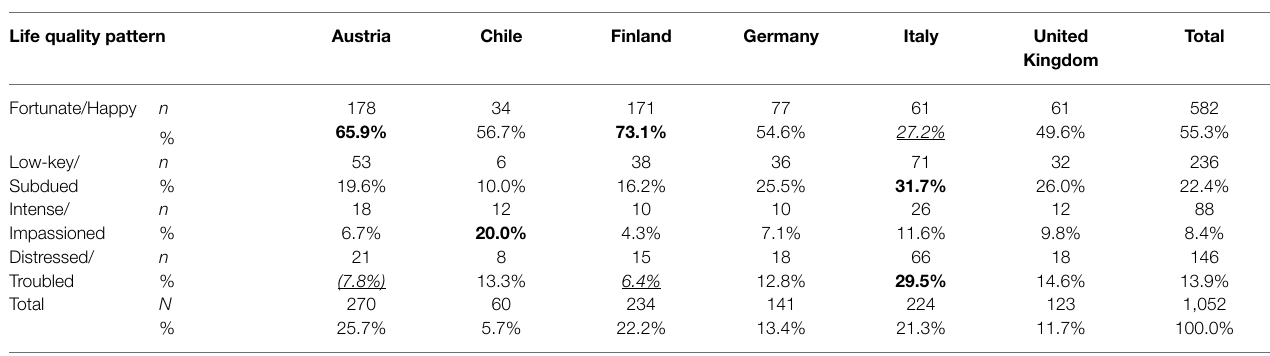
TABLE 11 | Trainees’ current life quality by nation. 1 Life quality